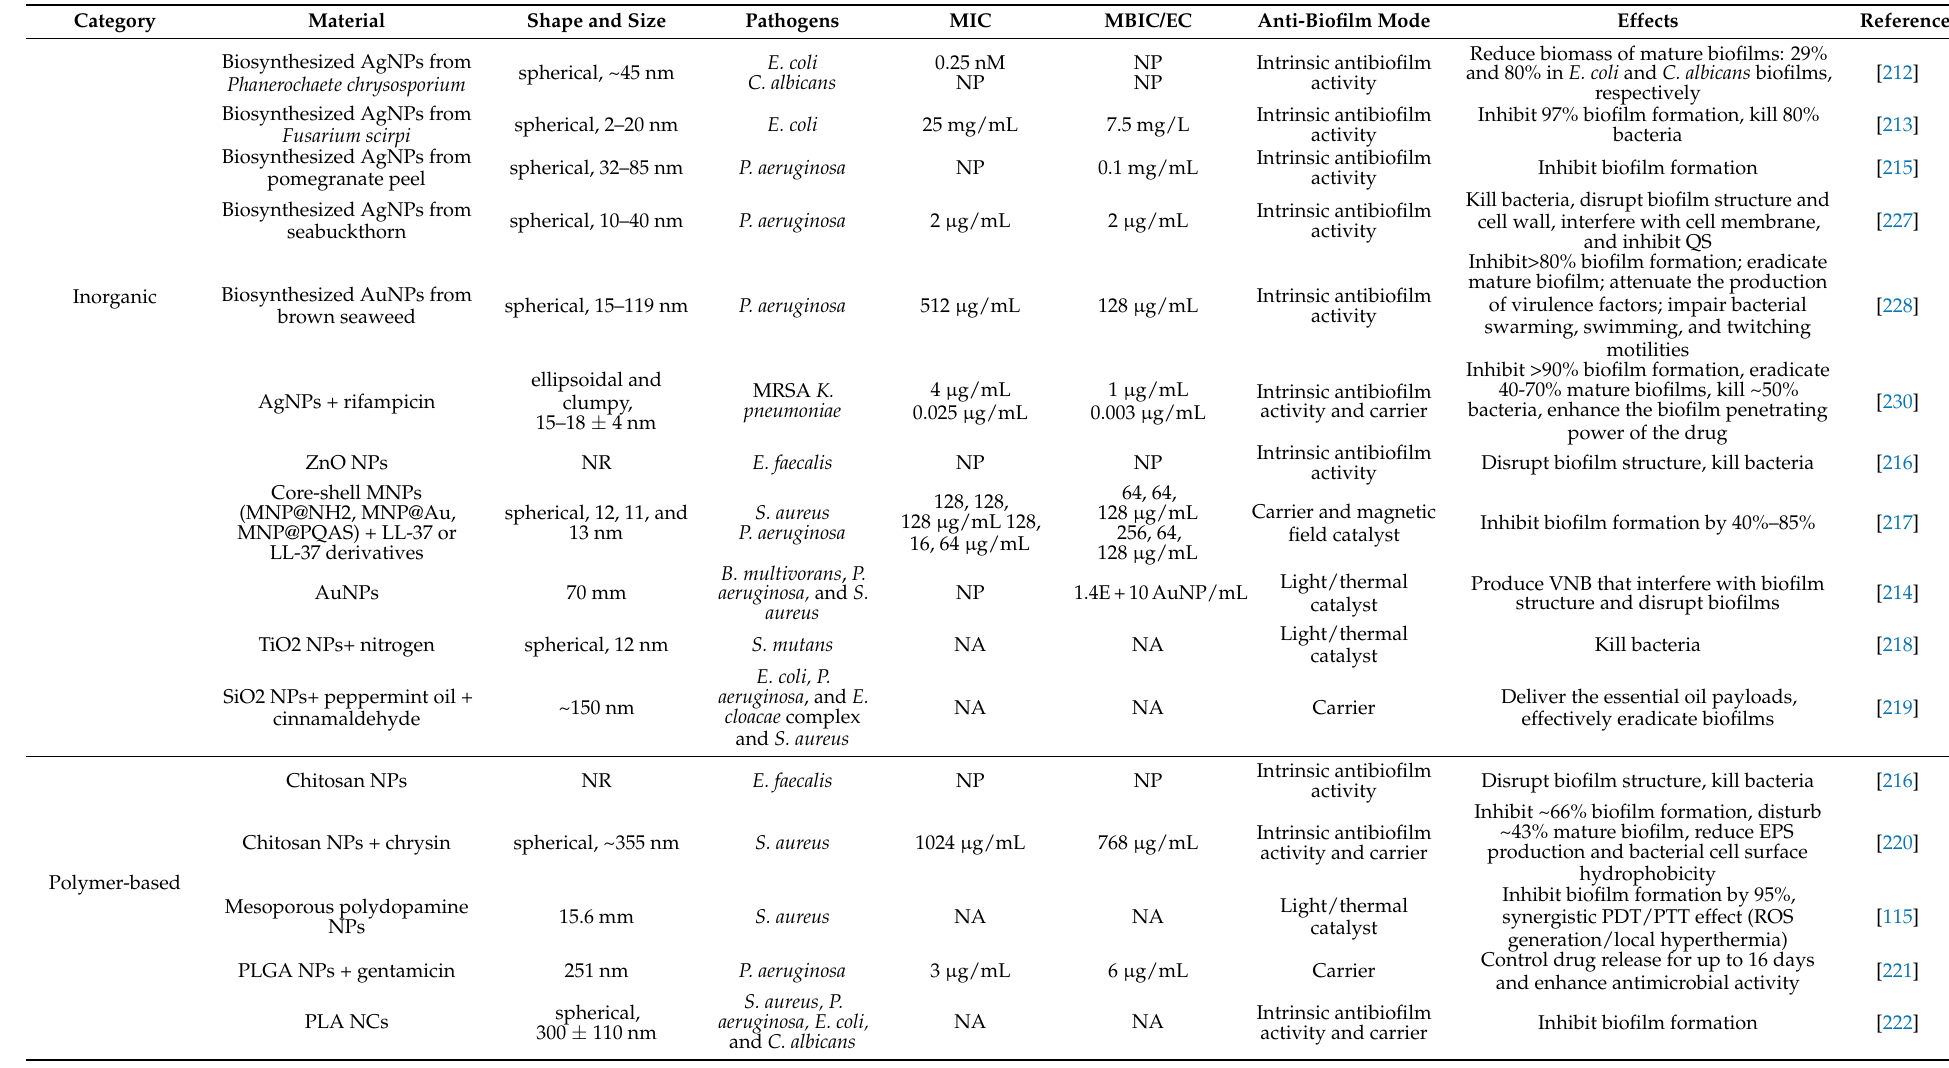
Table 4. Summary of nanomaterials used against biofilms on medical